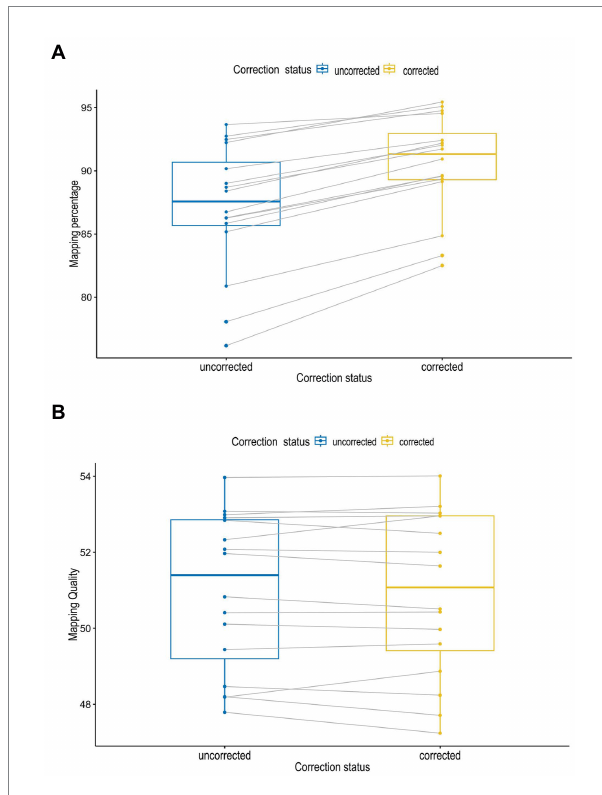
FIGURE 3 Mapping percentages (A) and mapping quality (B) of sequence reads before and after